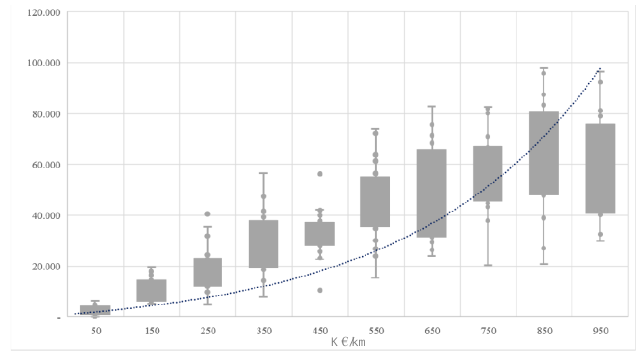
Figure 5. Operating costs (€) for each scenario when varying cable investment costs .